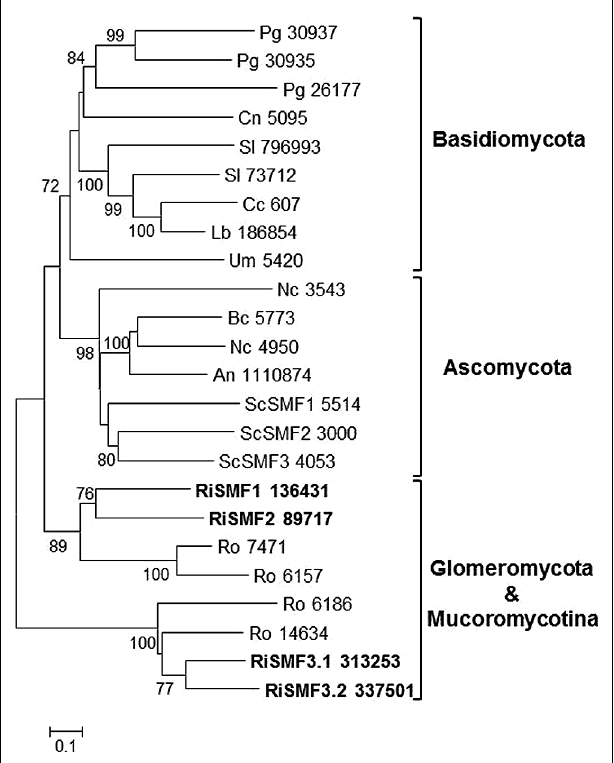
FIGURE 8 | Phylogenetic relationships of the Rhizophagus irregularis natural resistance-associated macrophage proteins (NRAMPs) with homologous sequences from selected species representative of the major fungal phyla. The Neighbor-Joining tree was created with MEGA 6. Protein JGI identification numbers are indicated. R. irregularis genes are shown in bold. Organisms: An, Aspergillus niger ; Bc, Botrytis cinerea ; Cc, Coprinopsis cinerea ; Cn, Cryptococcus neoformans ; Lb, Laccaria bicolor ; Nc, Neurospora crassa ; Pi, Piriformospora indica ; Pg, Puccinia graminis ;